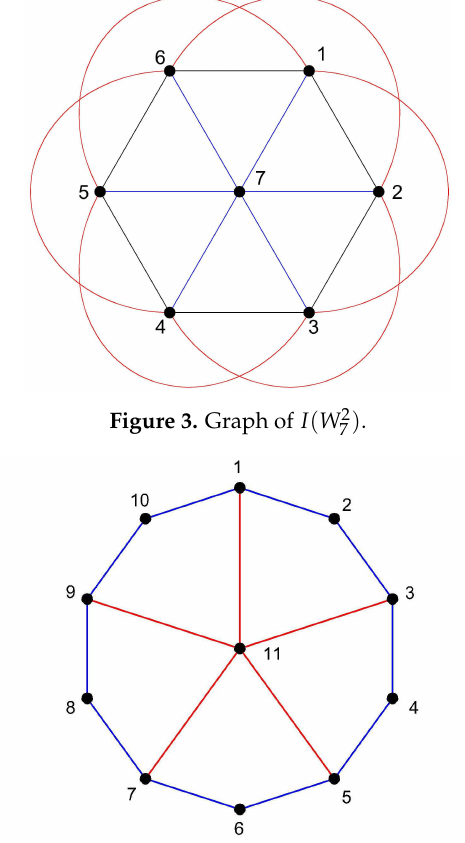
Figure 4. Graph of I ( G 11 )